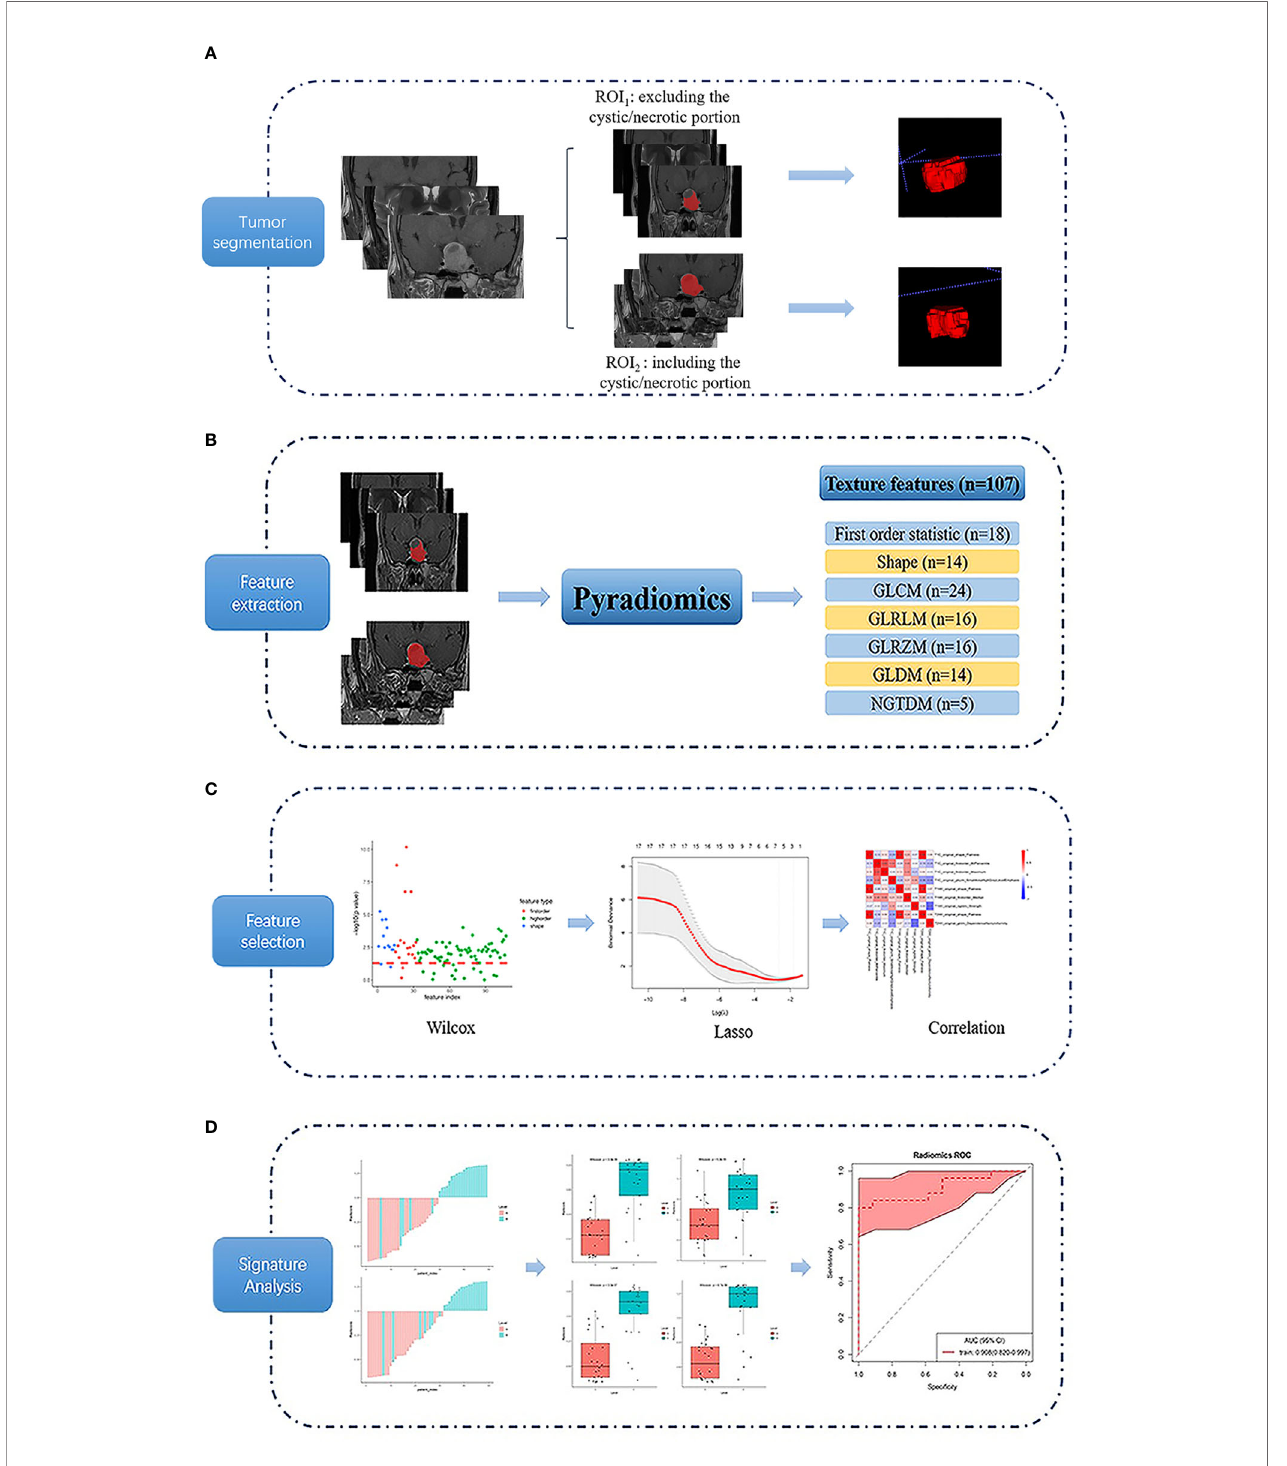
FIGURE 2 | Flow chart of the texture analysis process. Firstly, a region of interest (ROI) was drawn using 2 segmented methods (ROI 1 , excluding the cystic/necrotic portion, and ROI 2 , containing the whole tumor area) on coronal T1-weighted, T2-weighted, and contrast-enhanced T1-weighted images (A) . Then 107 texture features were extracted (B) , and the least absolute contraction and selection operator (LASSO) was used for feature selection (C) . Finally, the differentiating performance of the optimal features was analyzed (D)